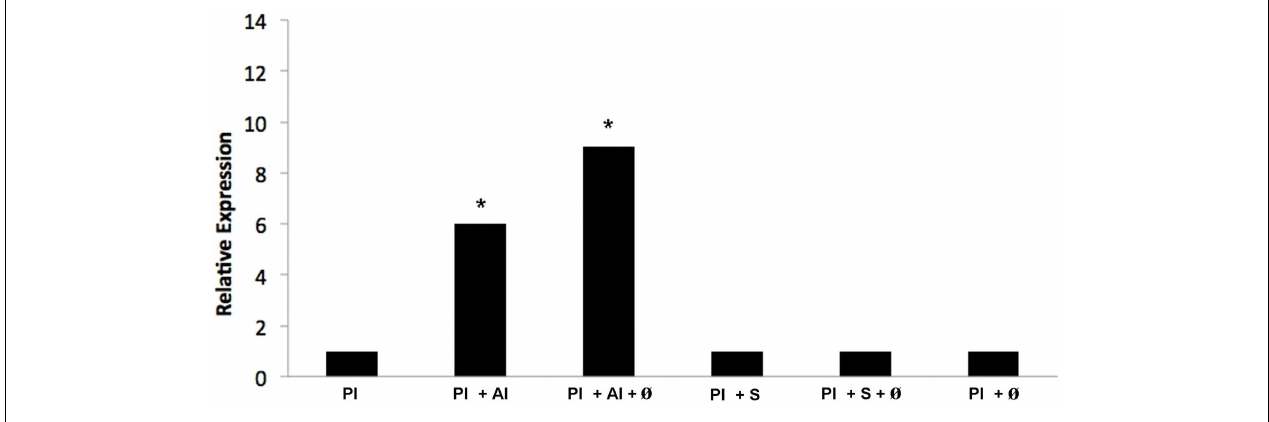
FIGURE 8 | Quantification of the mRNA expression of the methylcitrate dehydrogenase gene of P. lutzii infecting macrophage during exposure to argentilactone and sulfamethoxazole by quantitative qRT-PCR. (1) P. lutzii (Pl); (2) P. lutzii (Pl) + argentilactone (Al);